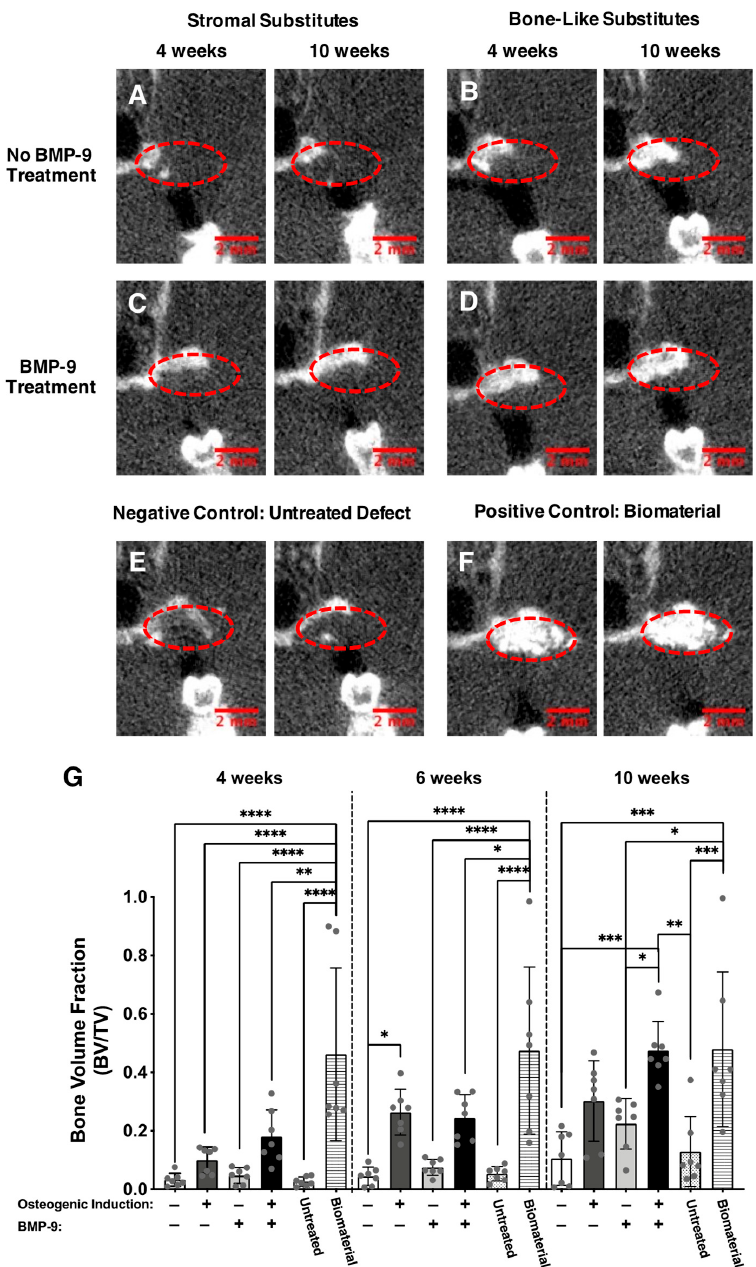
Figure 4. Microcomputed tomography imaging and analysis of the implantation sites. ( A – F ) Rep- resentative coronal plane images of the implantation sites (red dotted circles) showing alveolar bone preservation (white) following tooth extraction either four and ten weeks after grafting. Scale bars: 2 mm. ( G ) The ratio of bone volume (BV) reported on the tissue volume (TV), also named bone volume fraction (BVF), was calculated at the implantation site four, six, and ten weeks after implantation. Each gray dot represents an implantation site. (Two-way ANOVA with a Bonferroni’s multiple comparison post-hoc test, * p < 0.05, ** p < 0.01, *** p < 0.001, **** p <